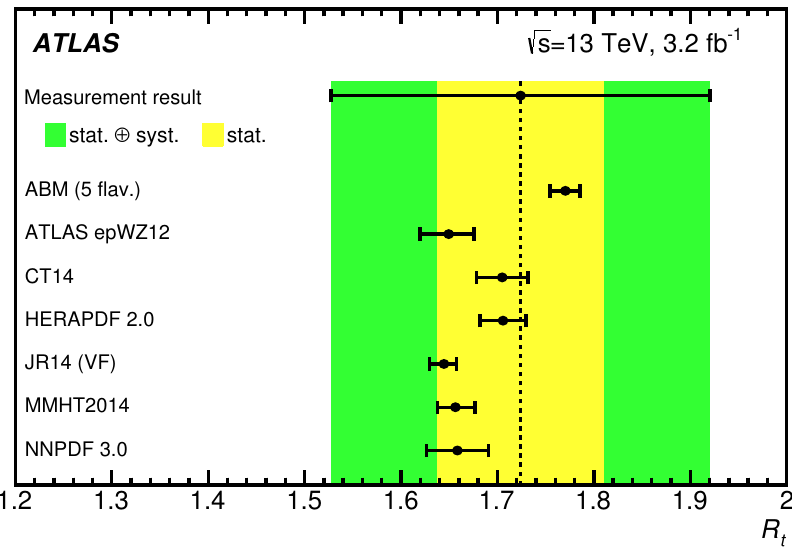
Figure 6 . Comparison between observed and predicted values of R t = (cid:27) t NLO precision [7, 8] in the five-flavour scheme and given for di (cid:11) erent NLO PDF sets. The uncertainty includes the uncertainty in the renormalisation and factorisation scales, as well as the combined internal PDF and (cid:11) s uncertainty. The dotted black line indicates the measured value. The combined statistical and systematic uncertainty of the measurement is shown in green, while the statistical uncertainty is represented by the yellow error band. Predictions for all presented PDF sets are within the statistical uncertainty of the